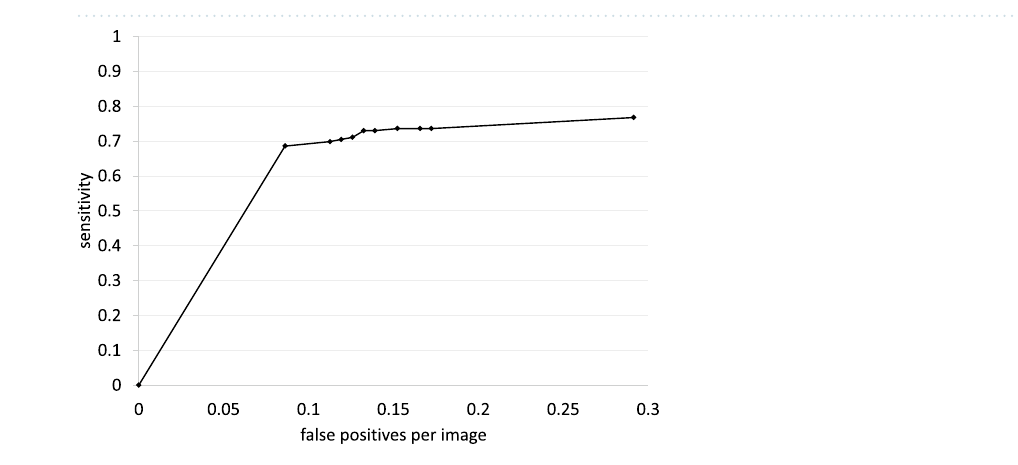
Table 2. Detection and segmentation performance of deep learning-based model in the test dataset.